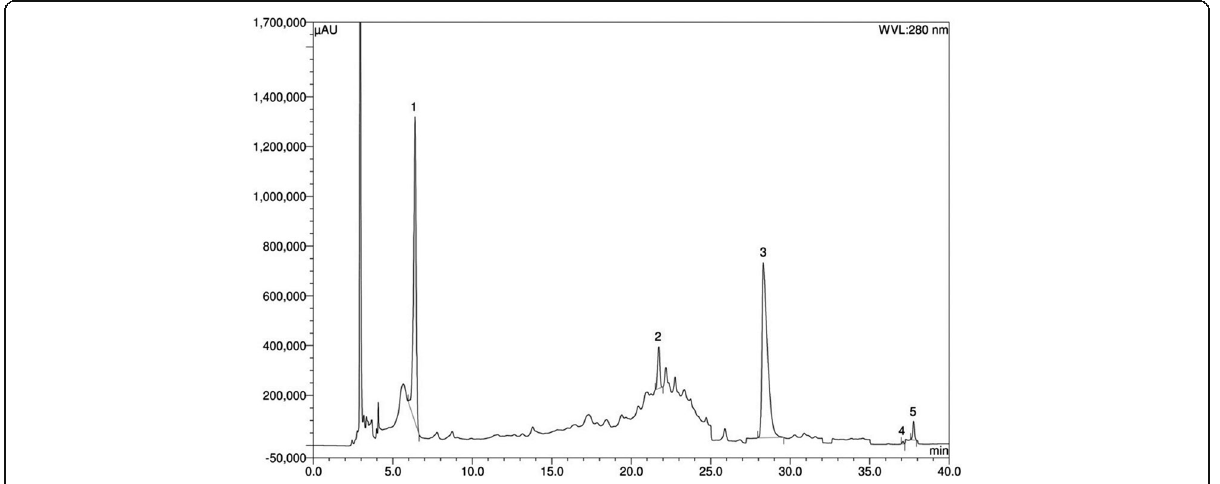
Fig. 1 HPLC chromatogram of ethanol extract of Syzygium cumini . Peaks: 1, Gallic acid; 2, ( − )-epicatechin; 3, ellagic acid; 4, quercetin; 5, trans -cinnamic acid